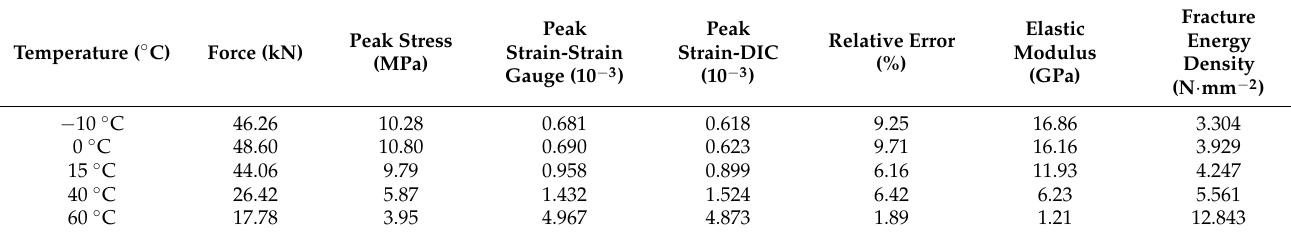
Table 4. Results of MPUC uniaxial tensile experiment.